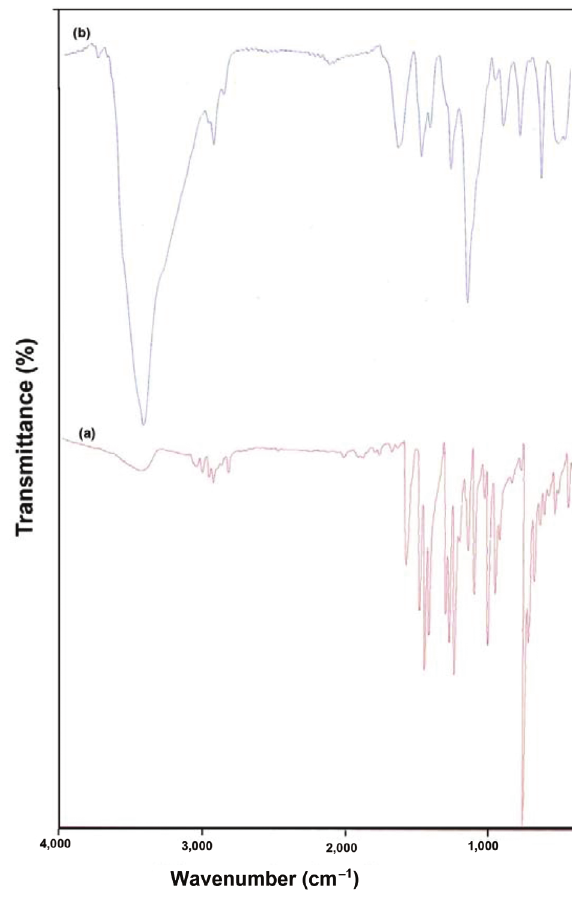
Figure 1: FT-IR spectrum of (a) as-synthesized thio-Schiff base ligand and (b) the posnjakite